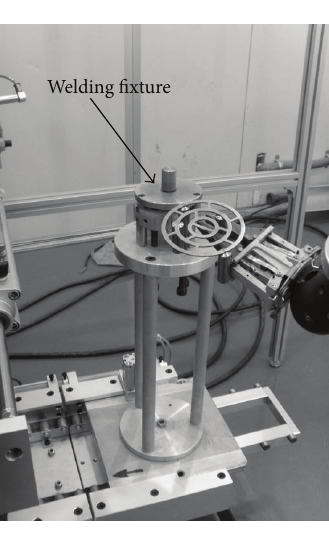
Figure 8: Photograph of the welding fixture using Zircaloy-4 weld specimen.